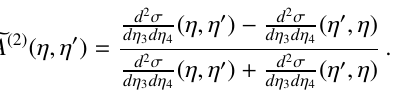
Figure 4. The di ff erential cross sections d σ/ d ( dP t ) as a function of the dP t “glueball filter” variable for the pp → ppK + K − reaction. Calculations were done for and in two dikaon invariant mass regions: (a) M 34 ∈ (1 . 45 , 1 . 60) GeV and (b) M 34 ∈ (1 . 65 , 1 . 75)